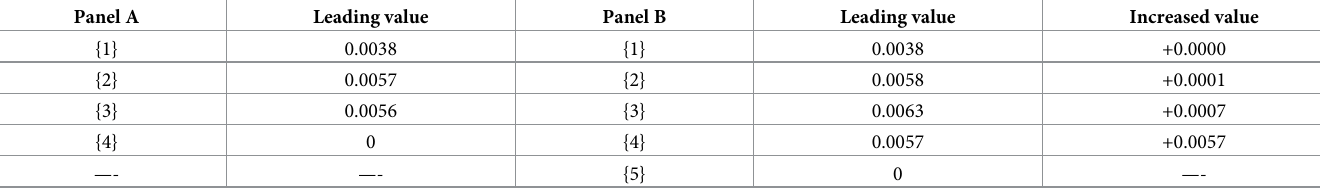
given that all the customers share identical preference parameters. Table 2. Each leading customer’s value and the change. Panel A Leading value Panel B Leading